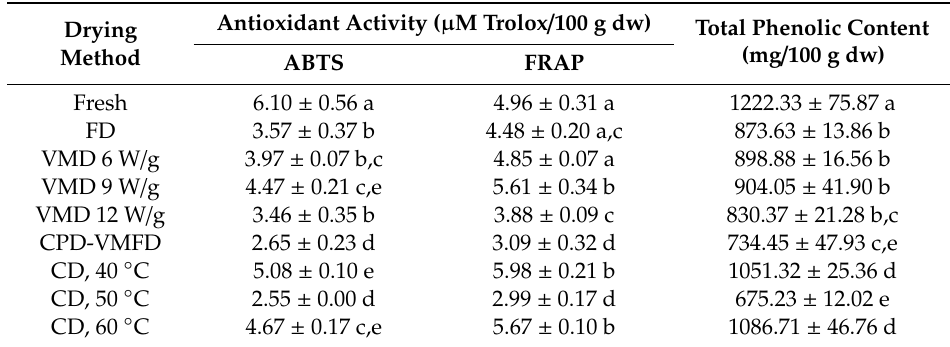
Table 1. E ff ect of drying methods and parameters on the antioxidant activity and total phenolic content (TPC) of Strobilanthes crispus